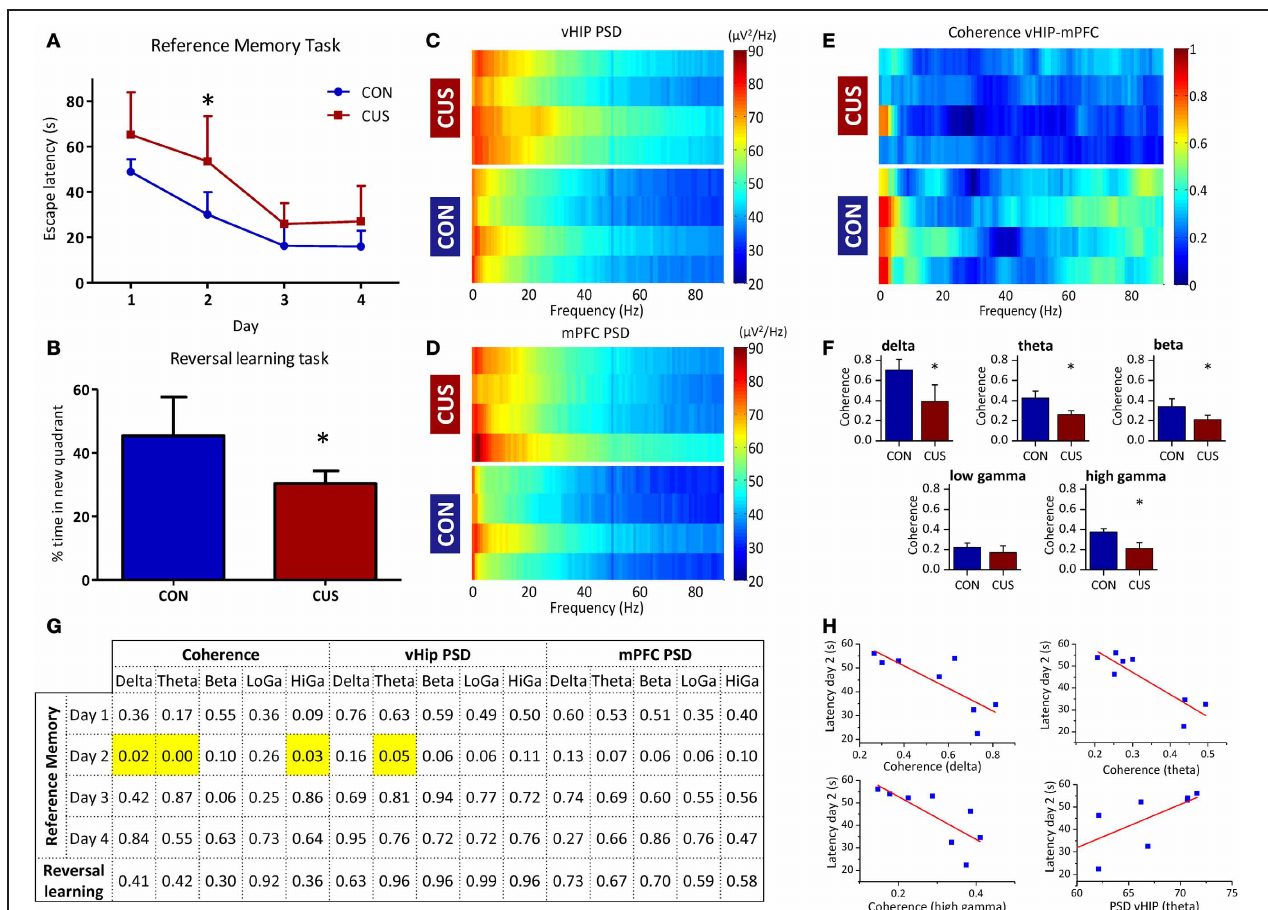
FIGURE 4 | CUS-induced changes in PSD and coherence correlate with impairments in cognitive performance. (A,B) Cognitive performance of the studied rats in water maze based tests for spatial reference memory and behavioral flexibility; (A) Learning curves of the reference memory task of control (CON) and chronically stressed (CUS) rats. (B) Average trial time in the new quadrant given as a percentage of the total escape latency for the reversal learning task. (C–F) Analysis of the LFP signals recorded in the vHIP and mPFC of the CON and CUS rats; Power Spectral Density (PSD) values of the vHIP (C) recordings and the mPFC (D) recordings, for controls (CON) and chronically stressed (CUS); (E) Spectral coherence of controls (CON) and